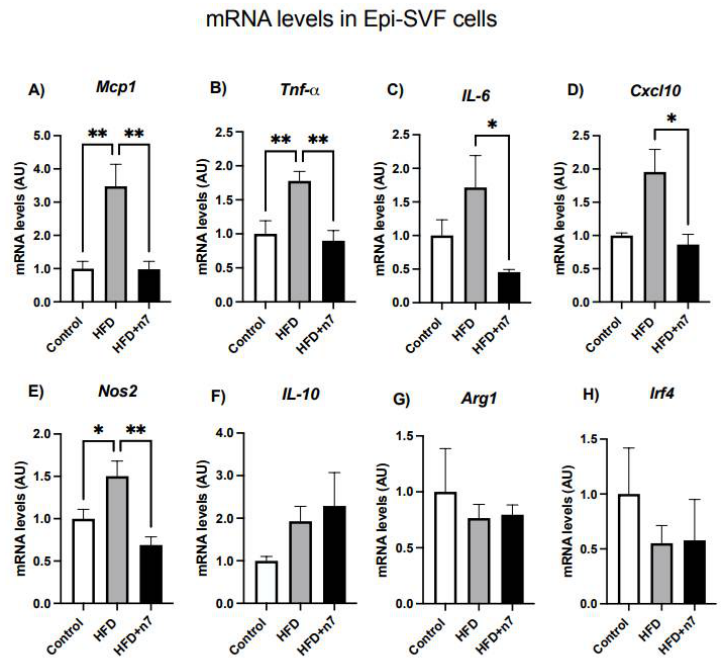
Figure 4. Effects of HFD and palmitoleic acid supplementation on mRNA levels of cytokines expressed by Epi-SVF cells. ( A ) Mcp1 , ( B ) Tnfa , ( C ) Il6 , ( D ) Cxcl10 , ( E ) Nos2 , ( F ) Il10 , ( G ) Arg1 and ( H ) Irf4. Values of mRNA were expressed as arbitrary units (AU) in relation to the control and corrected by the expression of the constitutive gene Gapdh . Values are mean ± SEM (n = 4, SVF cells were pooled from three mice). * p < 0.05 or ** p < 0.001 vs. Control .